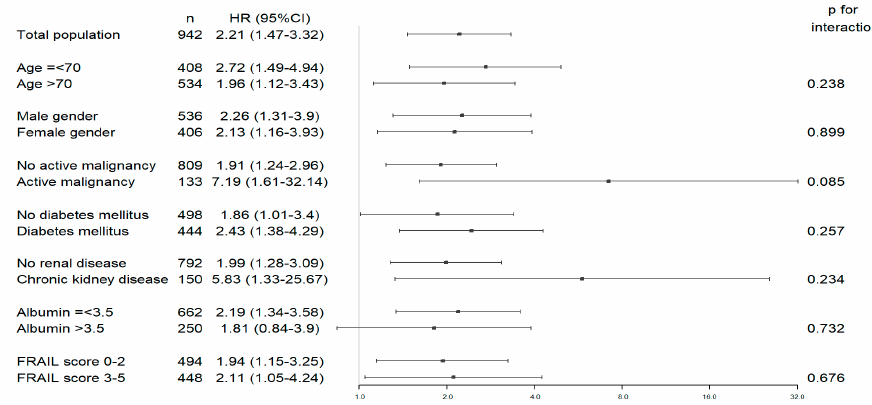
Figure 4. Sub-group analysis for lower ALT values and selected patients’ characteristics.